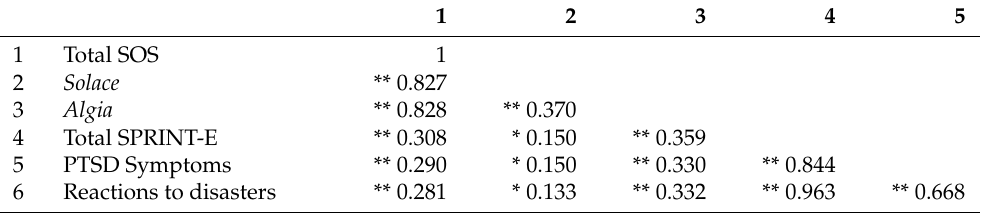
Table 3. Pearson correlations for total and dimensions of SOS and SPRINT-E.